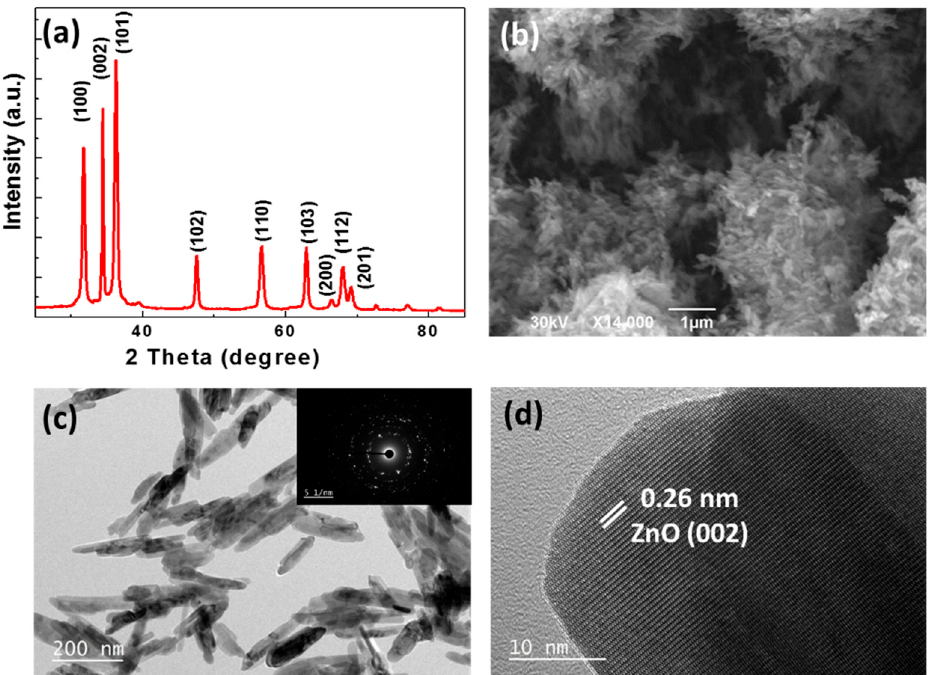
Figure 1. ( a ) X ‐ ray diffraction (XRD) pattern, ( b ) scanning electron microscopy (SEM), and ( c , d ) transmission electron microscopy (TEM) images of the ZnO nanorods (NRs) (the inset of Figure 1c is the selected area electron diffraction (SAED) pattern).